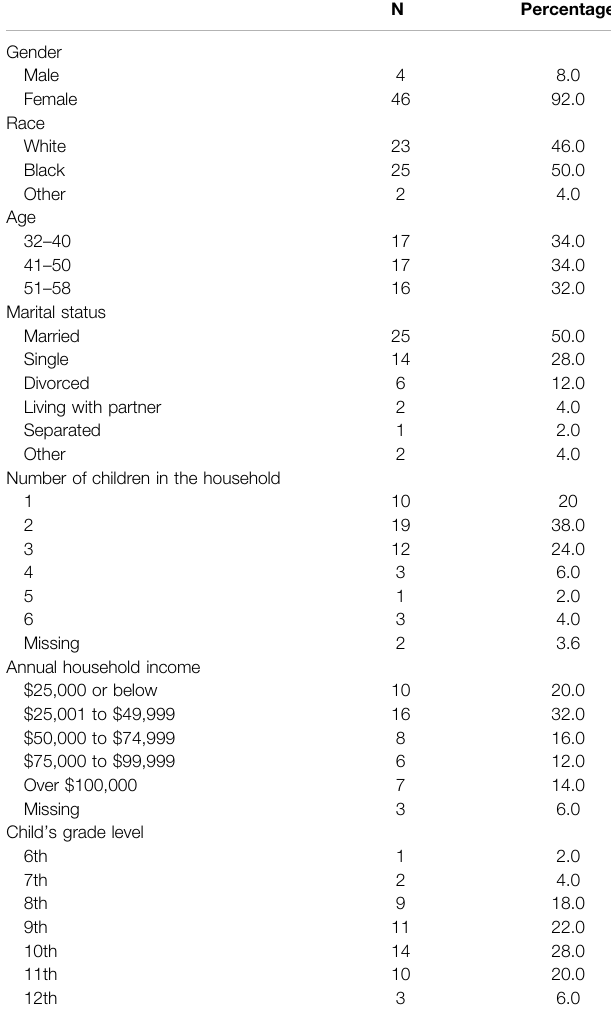
TABLE 1 | Demographics of sample (N (cid:1)